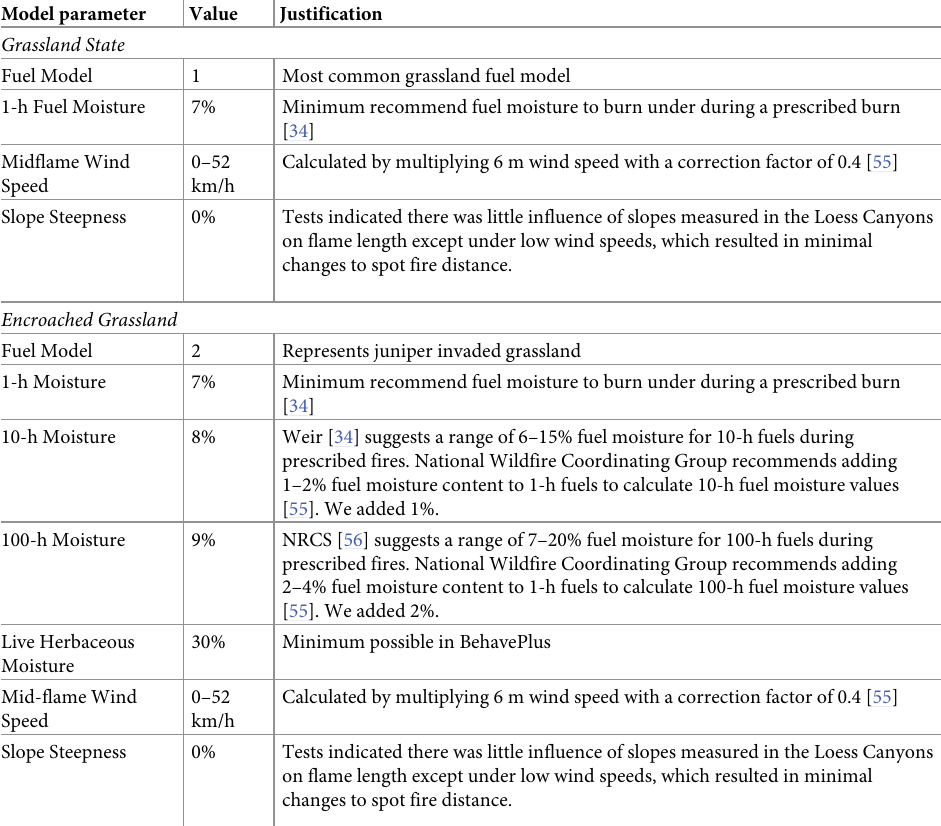
Table 2. Model parameters for calculating flame length values to be input into surface fire spotting distance